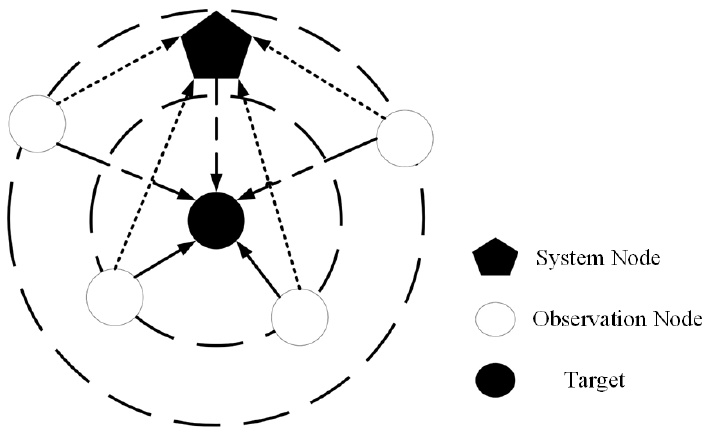
Figure 2. Distance observation